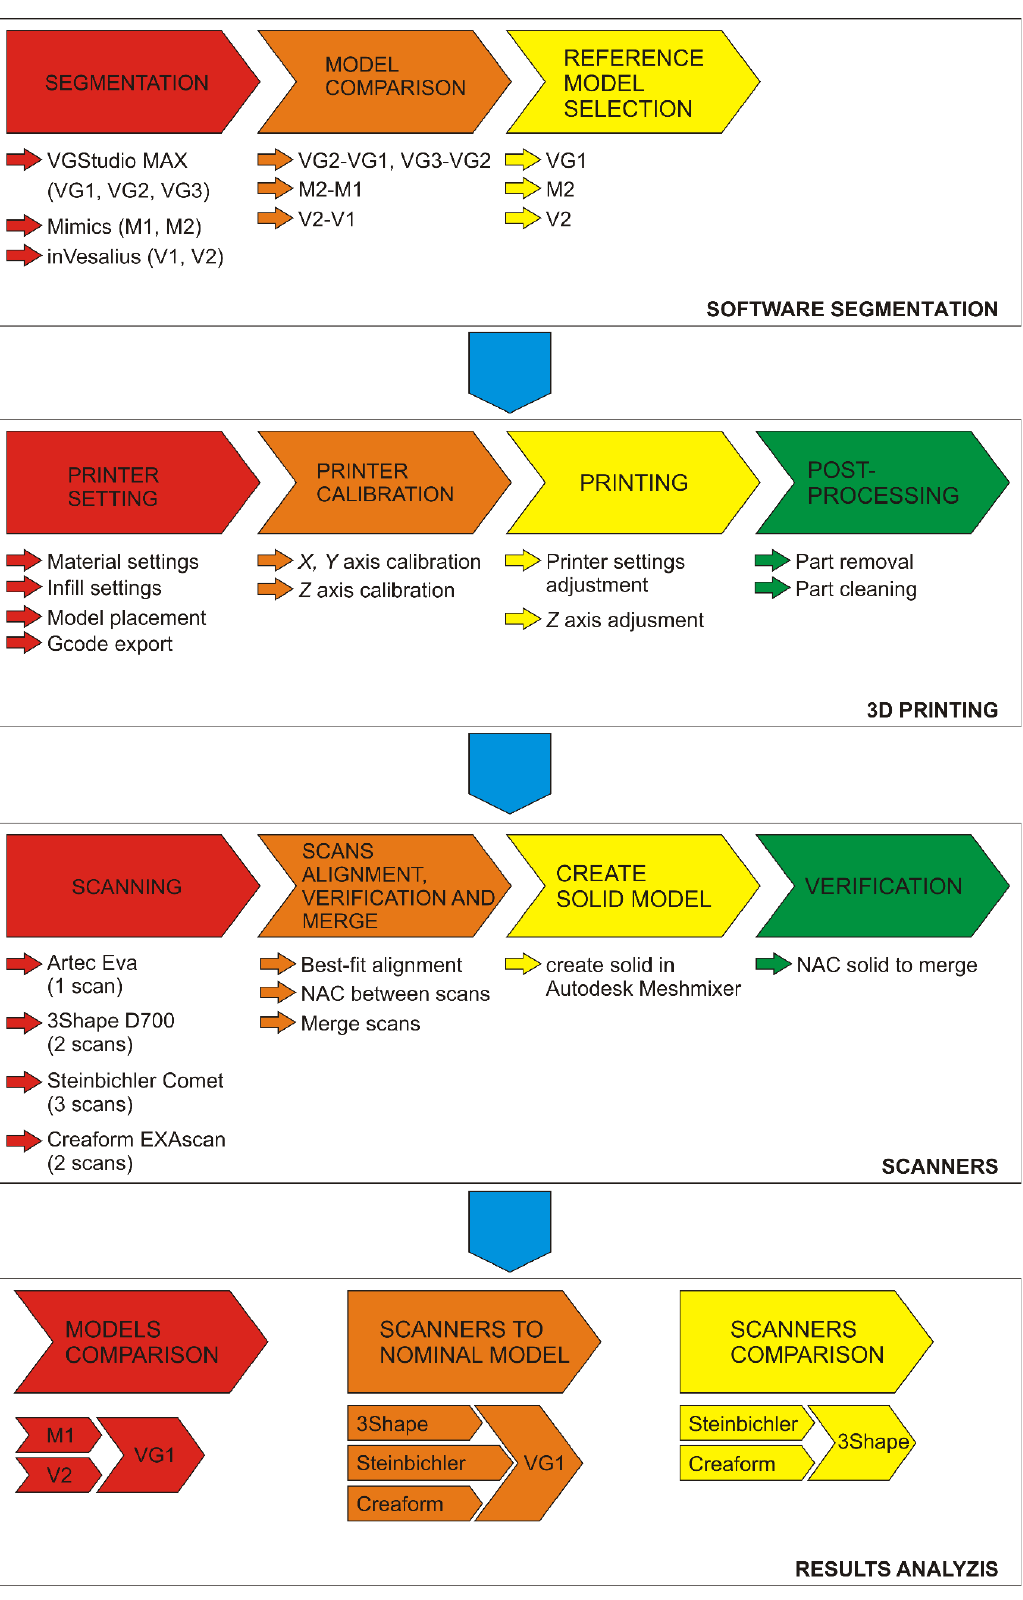
Figure 1. Design and evaluation methodology. VGStudio MAX different threshold models: VG1, VG2, and VG3; Mimics different threshold models: M1 and M2; inVesalius different threshold models: V1 and V2. Each represent models with different thresholds in the selected